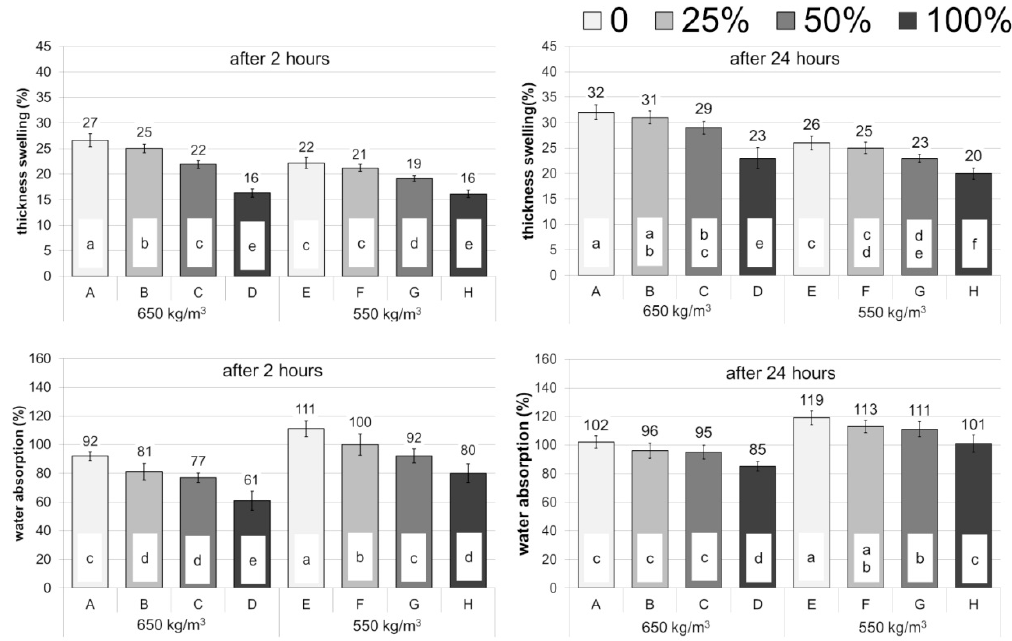
Figure 4. Physical properties of particleboards, a–f correspond to the homogeneous groups by Tukey test ( α = 0.05).